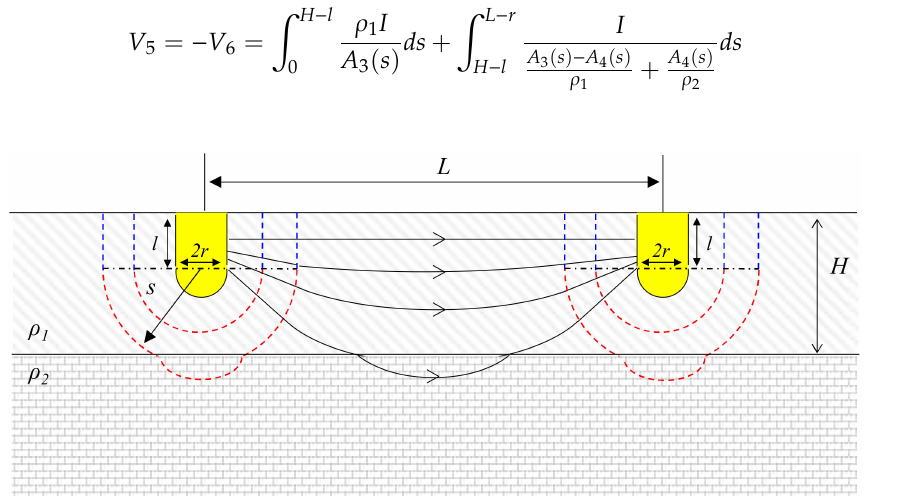
Figure 3. Definitions of the symbols used to represent cylindrical electrodes partially penetrating the upper layer of a two-layered ground